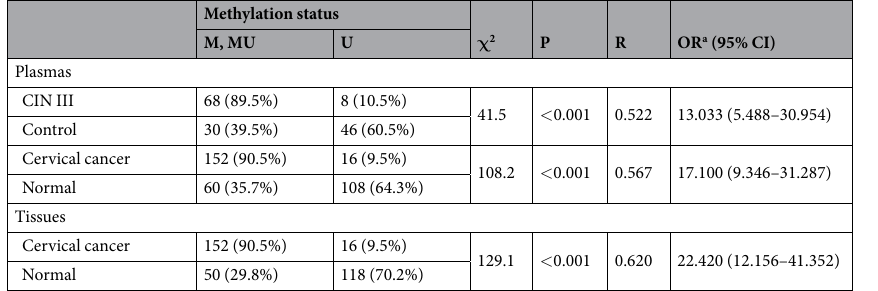
Table 1. The methylation status of MEG3 promoter in CIN III and cervical cancer patients. a OR (Odds